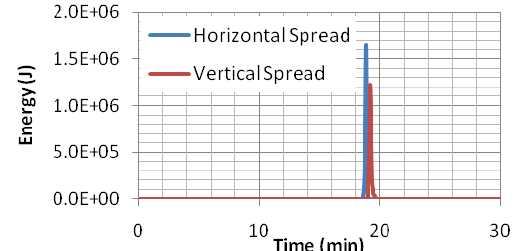
Fig. 12. Time-history of kinetic energy in 5-storey frame.